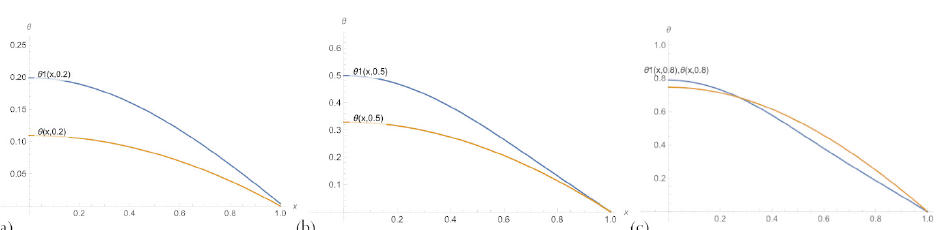
Figure 4. A comparison of PBA solutions (20) with an embedded neural network, θ 1 ( x , δ ) , n = 3 neurons, and an exact solution of the problem (11) for parameter values: ( a ) δ = 0.2; ( b ) δ = 0.5; ( c ) δ = 0.8.